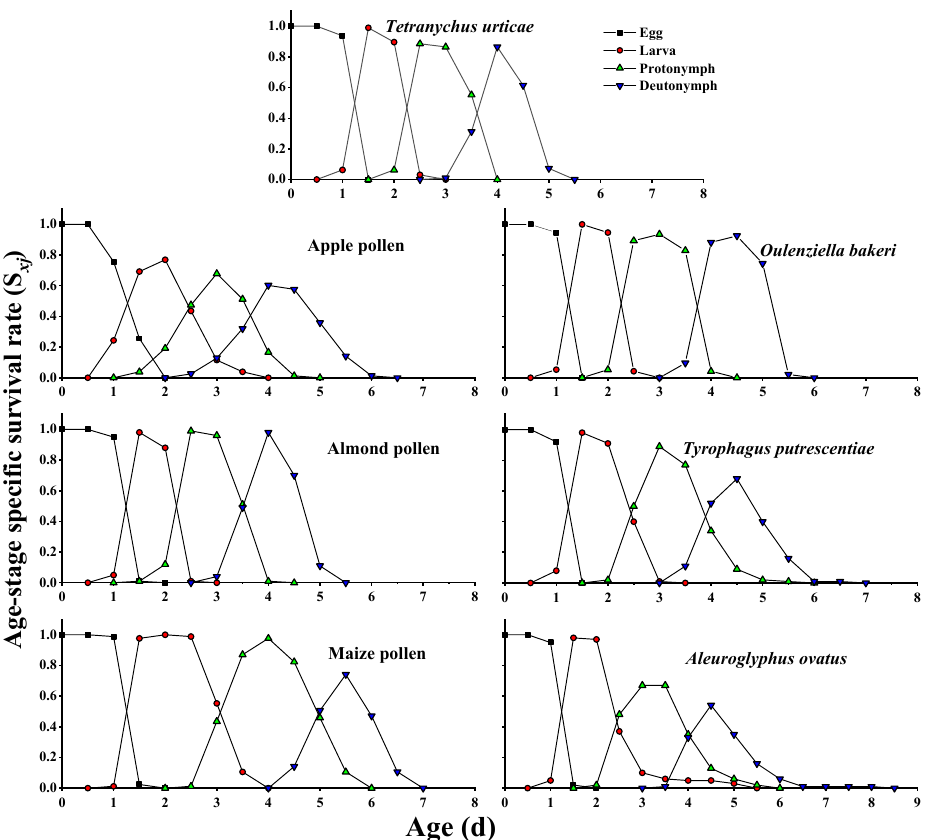
Figure 1. Age–stage ‐ specific survival rate ( S xj ) of pre ‐ adult stages of A. herbicolus on six alternative Figure 1. Age–stage-specific survival rate ( S xj ) of pre-adult stages of A. herbicolus on six alternative foods and its natural prey, T. urticae . foods and its natural prey, T. urticae